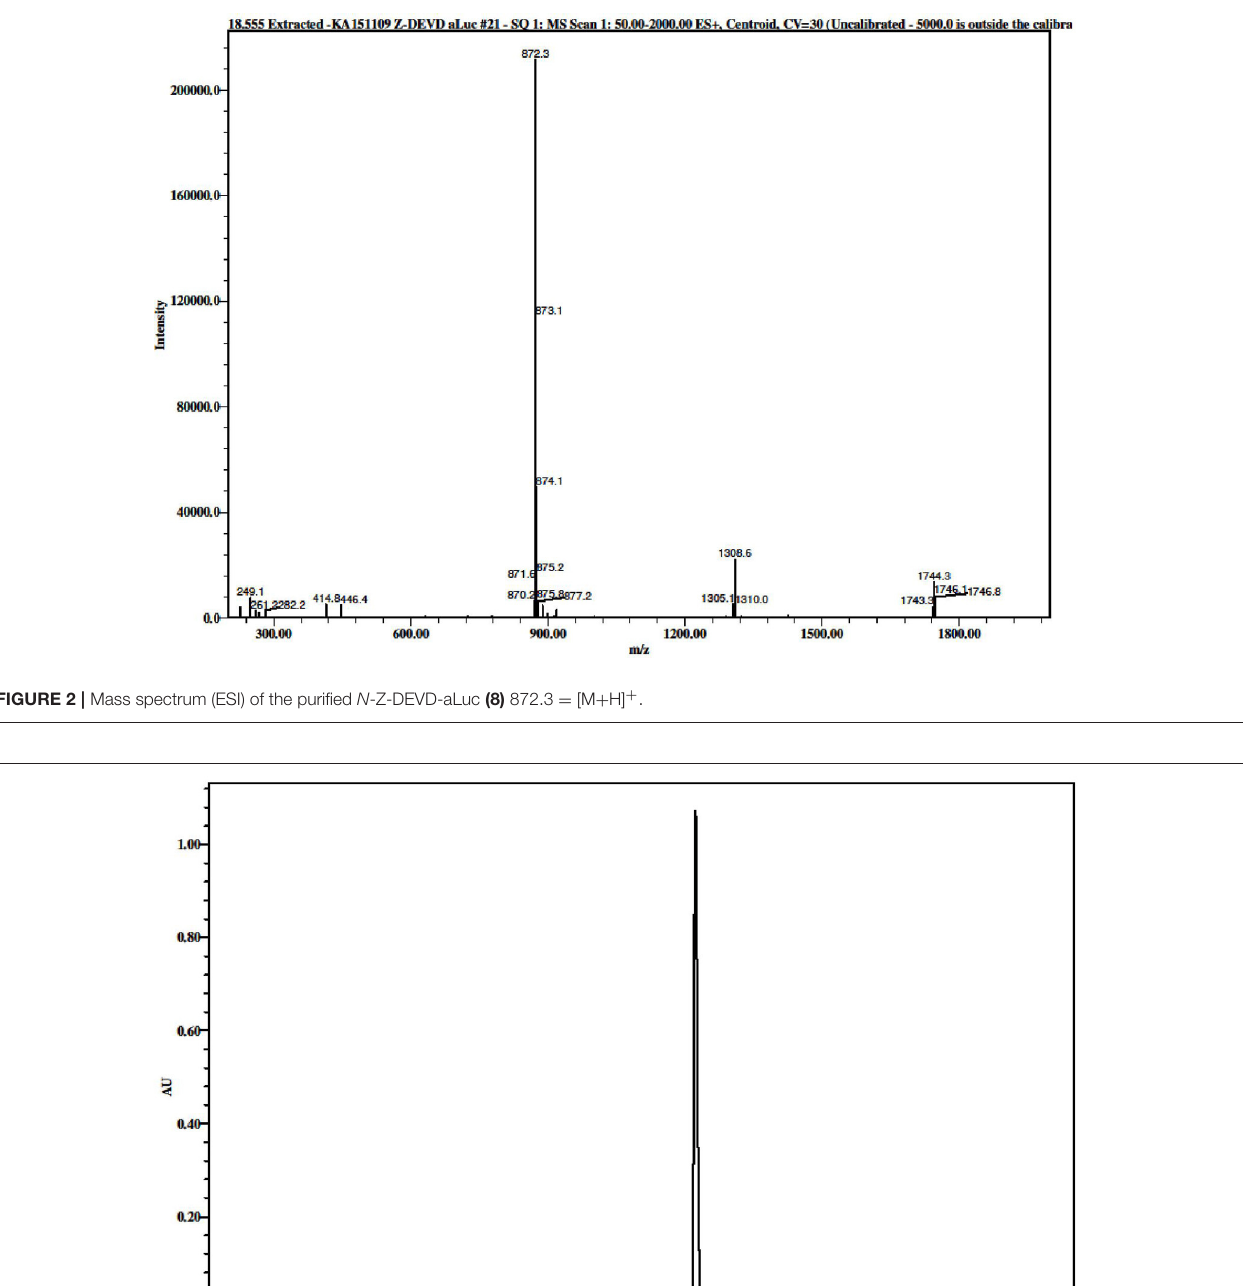
buffer was diluted with distilled water (five times concentrated lysis buffer: 250 mM HEPES, pH 7.4, 25 mM CHAPS, 25 mM DTT, and 50 µ l 1x concentration lysis buffer was added to the